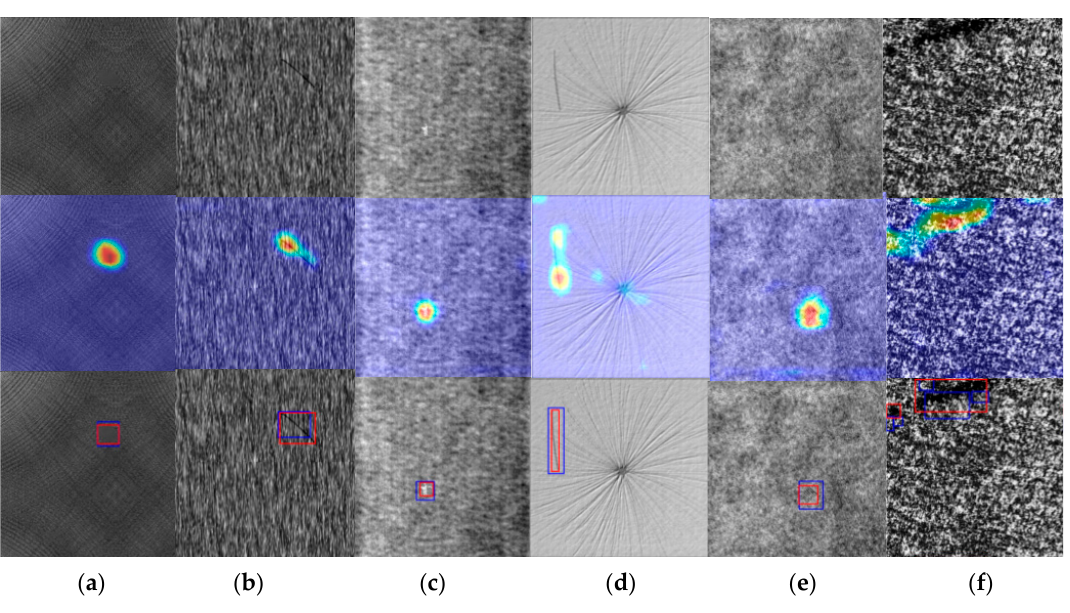
Figure 8. Examples of localization on DAGM_2007 defect dataset. From top to bottom are the original image, the combination of the original image and the heat map, and the location results of the defects. The Ground-Truth of the defect is marked with the red bounding boxes, while the localization results of the proposed method is marked with the blue bounding boxes. ( a ) classes1; ( b ) classes2; ( c ) classes3; ( d ) classes4; ( e ) classses5; ( f ) classes6.